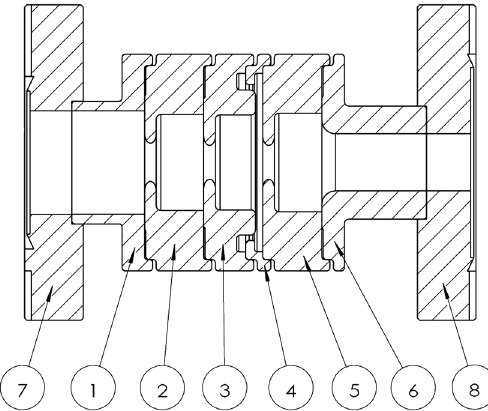
FIG. 6. Mechanical design of THU-CHK-#1. No. 1 to 6 are the disks of main cavity. No. 7 and No. 8 are Pearson flange [63] and ICF70 flange.